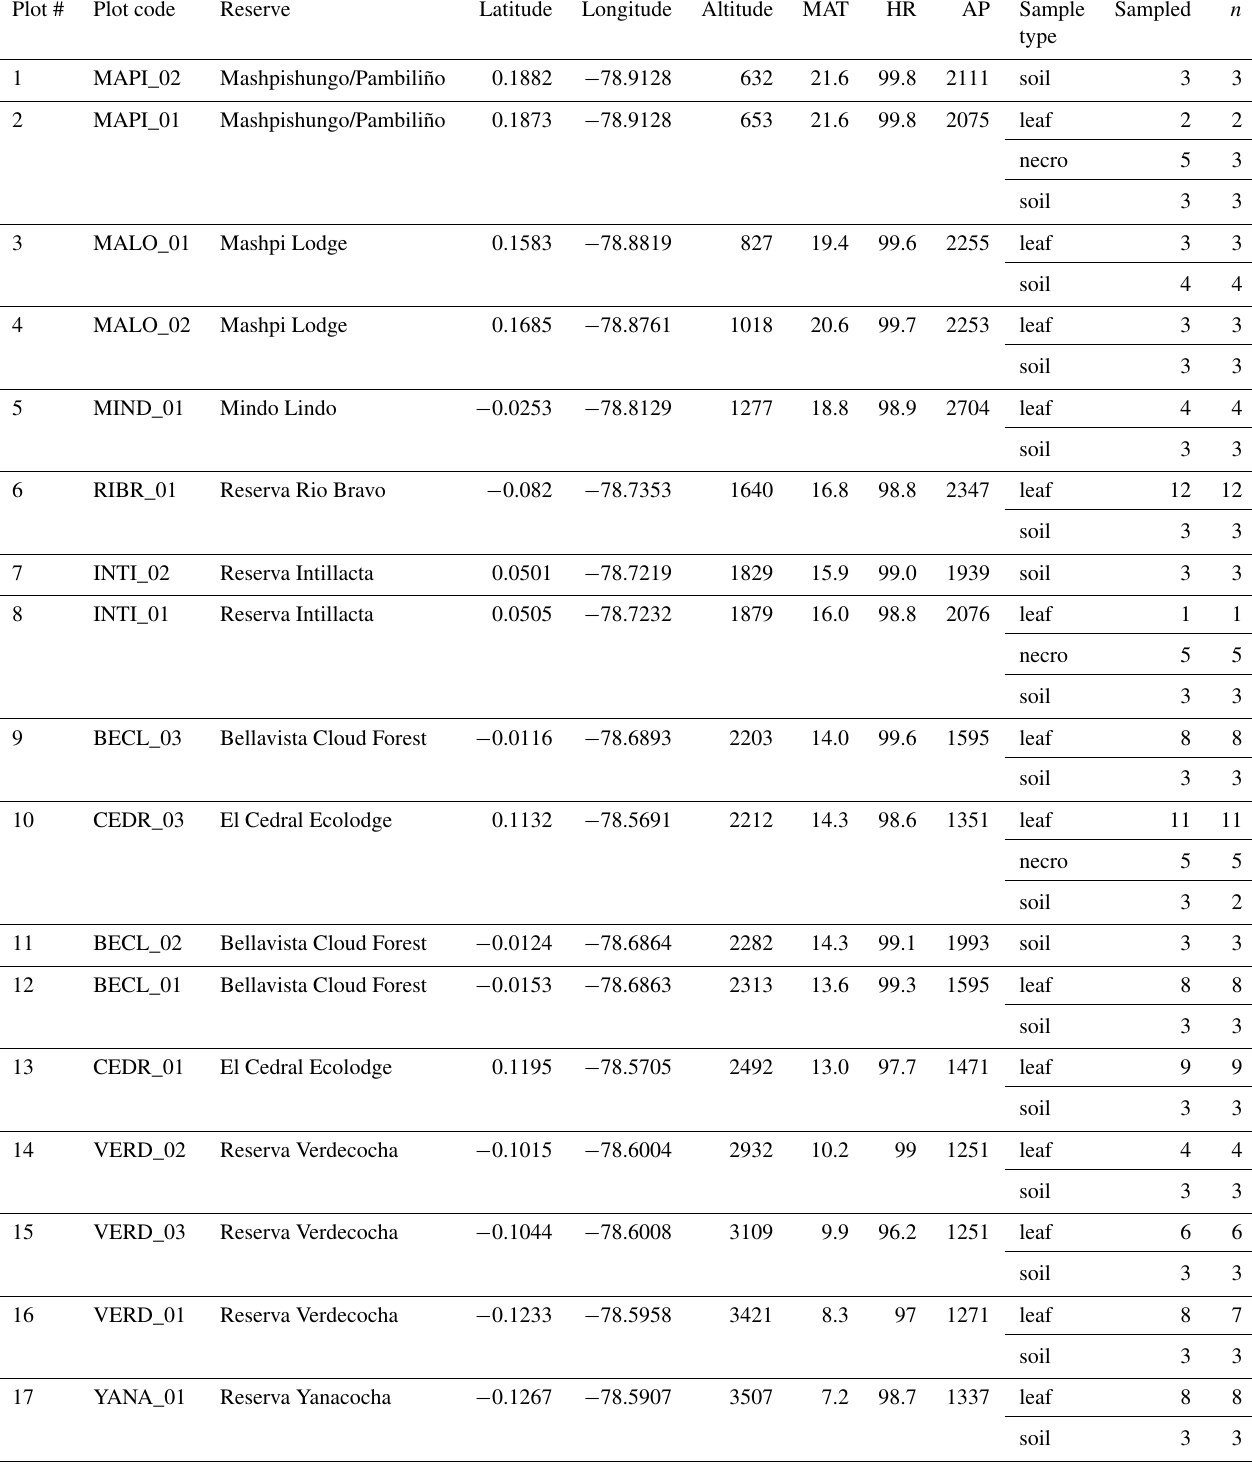
Table 1. Sampling table. Plot numbers refer to numbers in Fig. 1. Plot codes refer to specific plots within the natural reserve, situated at their respective longitude and latitude. Altitude, temperature (MAT), humidity (HR), and precipitation (AP) data corresponding to each plot are included. Table notes what sample types were taken (sample type), how many were taken (sampled), and which samples were measured successfully and included in analysis ( n